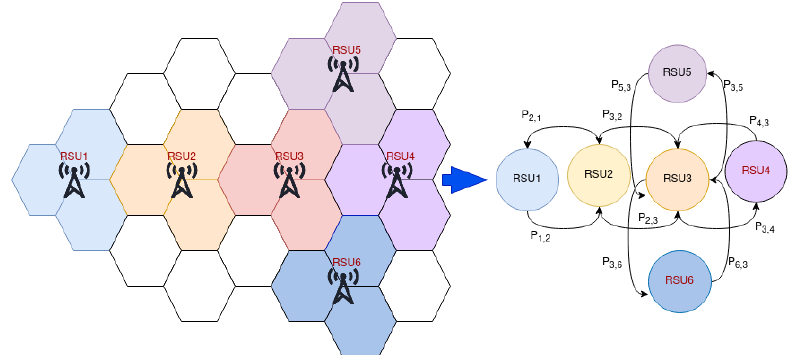
Figure 4. Roadside unit to Markov